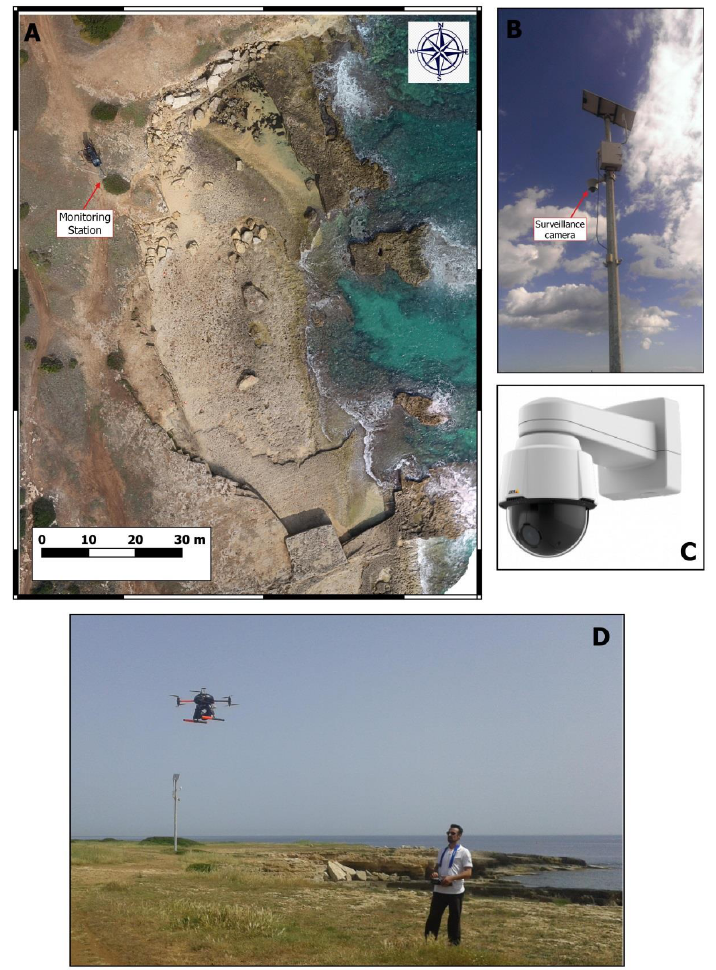
Figure 3. ( A ) Orthophoto (Resolution 1cm/pxl) of ancient Greek quarry located in the northern sector of the Maddalena Peninsula, the arrow shows the Monitoring Station. ( B ) Monitoring Station mounted on pole at 9m height. ( C ) HDTV camera. ( D ) Unmanned Autonomous Vehicle (UAV) survey operations in the studied area, the pole with Monitoring Station is also visible. In order to obtain an accurate georeferencing of the UAV data, we used the ground control point (GCP) net installed in 2015 and composed of 40 benchmarks regularly spaced along the quarry area (Figure 4A). Benchmarks positions were surveyed with real-time kinematic (RTK) GPS performing 1 h of acquisition for each point of the net. Colored markers, visible from 30 m of altitude, were placed on the benchmarks (Figure